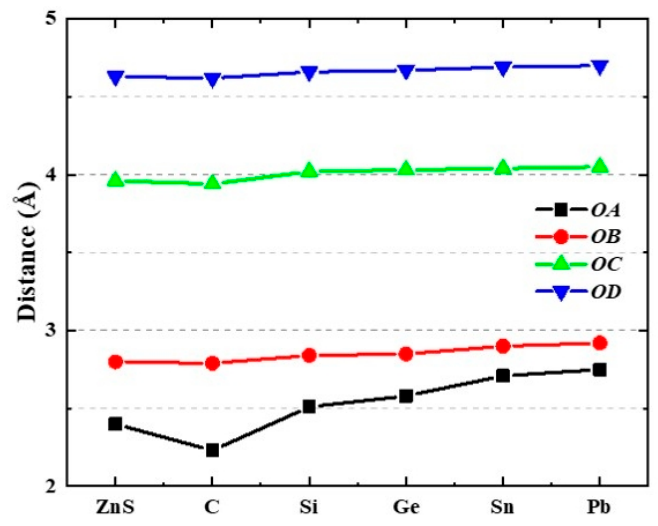
Figure 2. The interatomic distances from O atom to A , B , C , and D atoms, respectively.